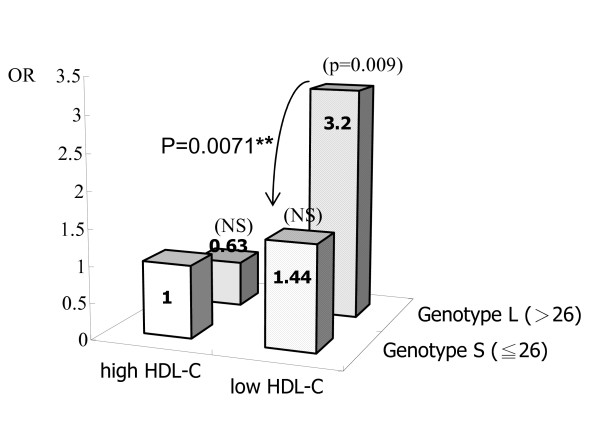
Age- and sex- adjusted odds ratio on stroke risk by HO-1 genotypes by HDL-C level. Low HDL-C status is HDL-C level less than 40 mg/dL in men or 50 mg/dL in women. P-values in parenthesis were obtained for each subgroup comparing with the reference group (low risk and genotype S), and those p values of ≧0.05 were not showed. Bold p value near curved arrow was obtained for comparing risk of genotype L with S in the high risk factor profile group. NS: p ≧0.05. *: p < 0.05. **: p < 0.01. ***: p < 0.001